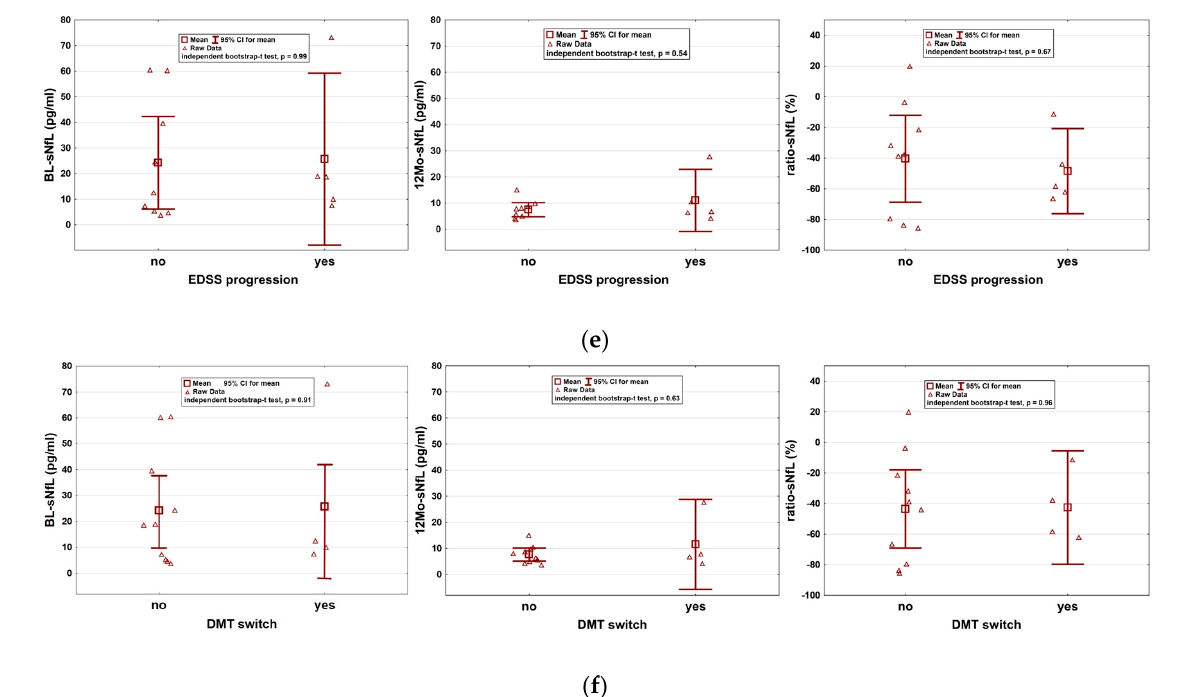
Figure 2. Impact of CLAD on sNfL and predictive utility of sNfL for treatment response. ( a ) SNfL is significantly reduced by CLAD administration ( p = 0.0008) at 12 months from therapy start. ( b – f ) We found no correlation between sNfL at BL (BL ‐ sNfL, left), sNfL at 12 months from CLAD start (12Mo ‐ sNfL, middle) and the sNfL ratio of both time points (ratio ‐ sNfL, right) and various parameters for disease activity. EDSS progression was defined as 6 months confirmed Expanded Disability Status Scale (EDSS) progression. CI: confidence interval; NEDA: no evidence of disease activity; MRI: magnetic resonance imaging; EDSS: Expanded Disability Status Scale; DMT: disease